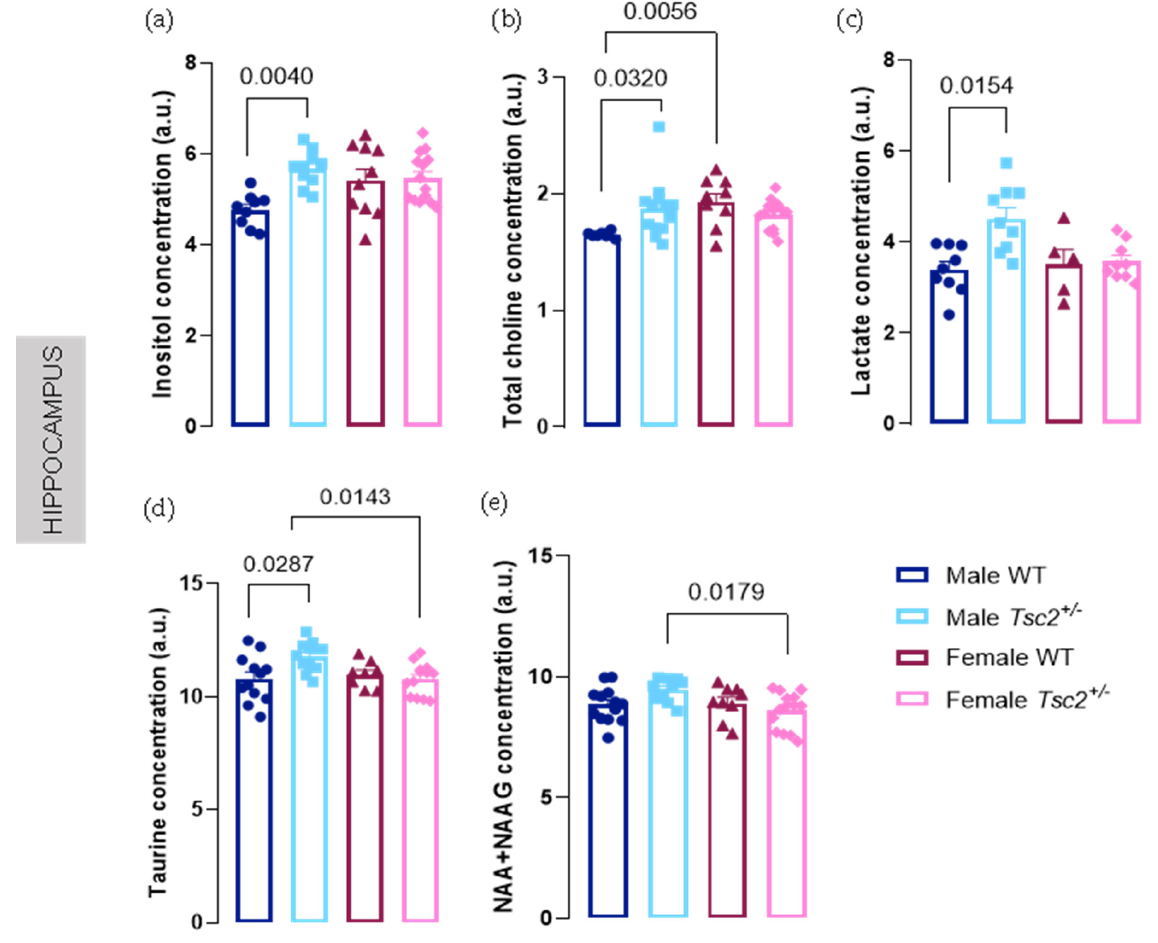
Figure 3. Hippocampal neurochemical profile of male Tsc2 +/ − mice was altered. It was found that concentration levels of ( a ) total choline, ( b ) inositol, ( c ) lactate, ( d ) taurine, and ( e ) NAA+NAAG were augmented using 1 H-magnetic resonance spectroscopy (MRS). The results are expressed as mean ± SEM. Inositol: 43 animals (9 male WT, 10 male Tsc2 +/ − , 10 female WT, 14 female Tsc2 +/ − ); total choline: 42 animals (7 male WT, 13 male Tsc2 +/ − , 9 female WT, 13 female Tsc2 +/ − ); lactate: 32 animals (9 male WT, 9 male Tsc2 +/ − , 5 female WT, 9 female Tsc2 +/ − ); taurine: 45 animals (12 male WT, 12 male Tsc2 +/ − , 8 female WT, 13 female Tsc2 +/ − ); NAA+NAAG: 46 animals (13 male WT, 10 male Tsc2 +/ − , 9 female WT, 14 female Tsc2 +/ − ). Statistical analysis was carried out using Kruskal–Wallis, followed by Dunn’s multiple comparison test.